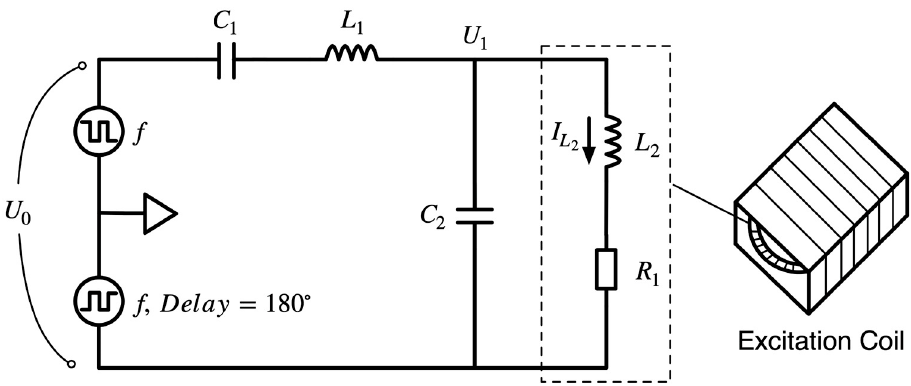
Figure 4. Magnetic fl uxgate drive signal modulation excitation circuit structure.